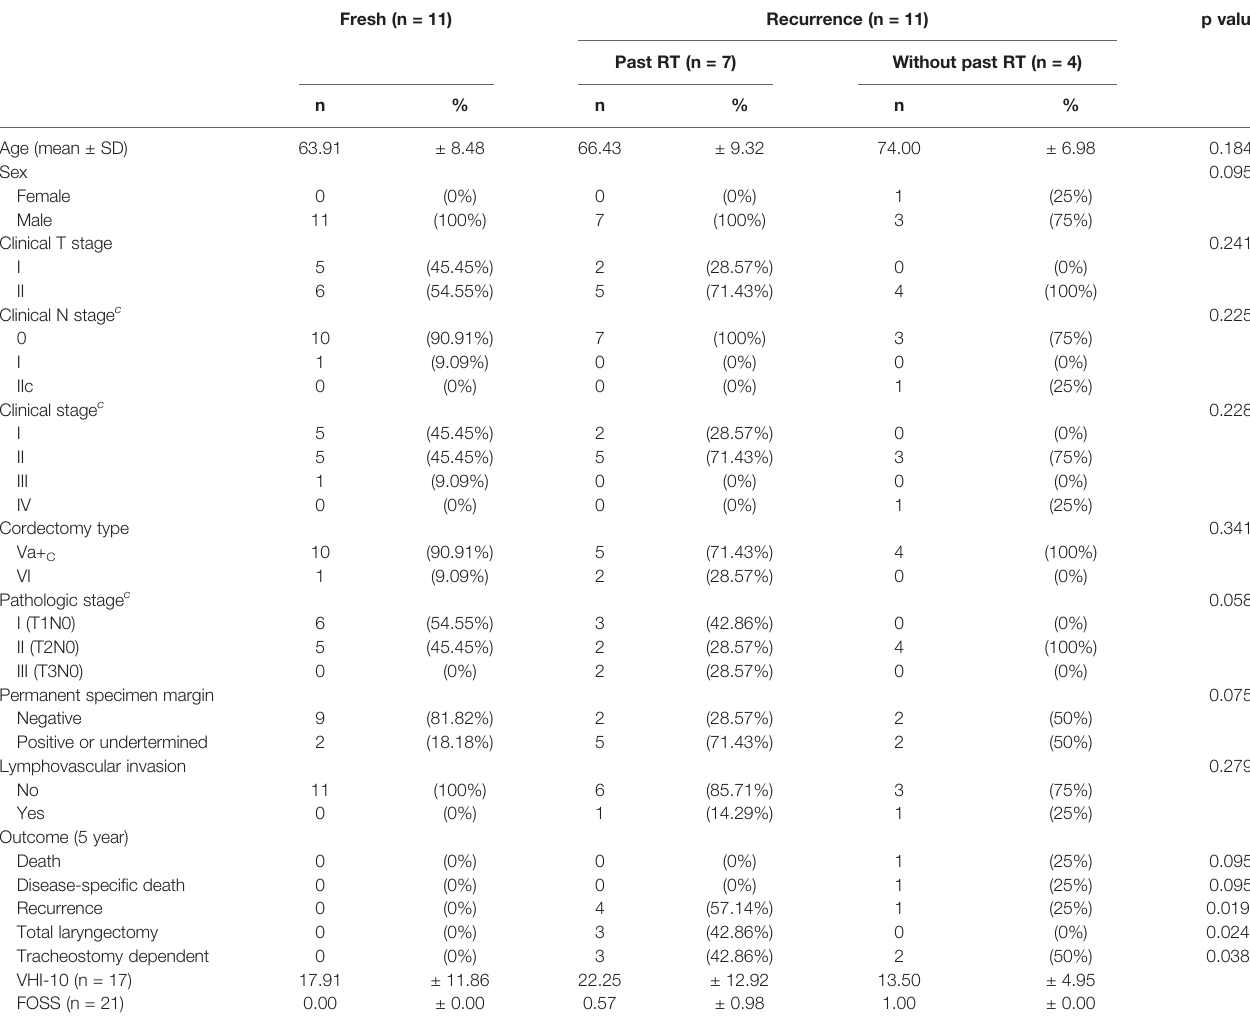
Seven patients of the recurrent cancer group had past history of radiation failure. c Chi-square test. Fisher ’ s exact test. *p <